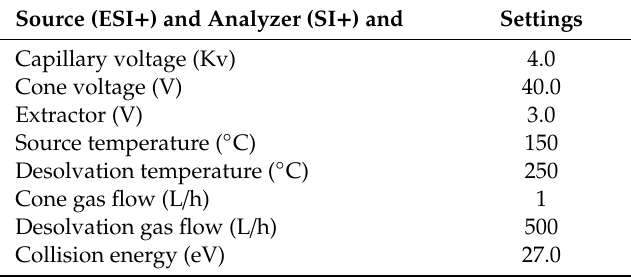
Table 1. The optimal MS parameters for plasma determination of clotrimazole (CTZ). Source (ESI+) and Analyzer (SI+)